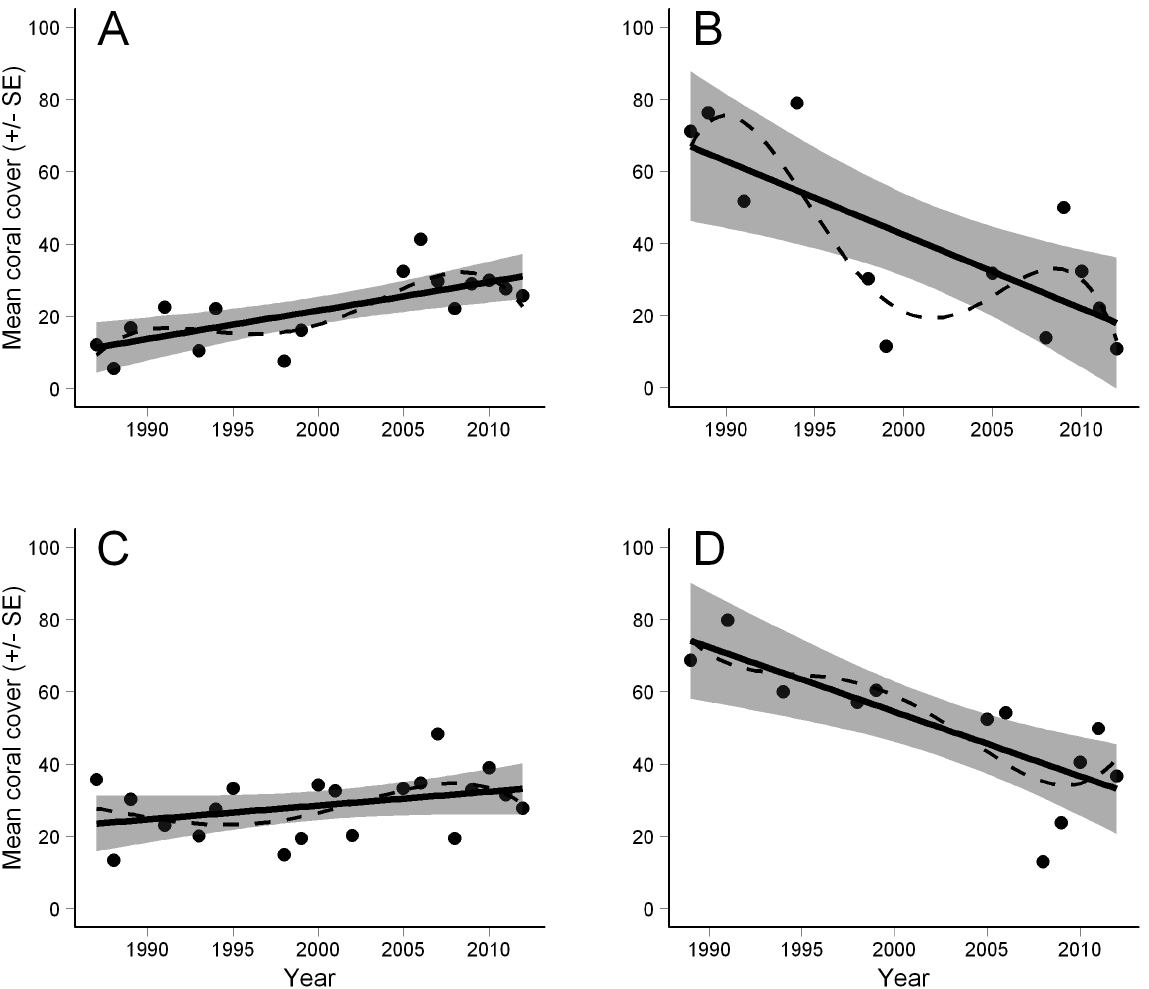
Figure 4. Coral cover through time at Ningaloo Reef weighted by area sampled ( 6 SE). Lines fitted using a linear regression (solid line) and 4 th order polynomial regression (dashed line). A) North, B) North-east, C) Central, and D) South.